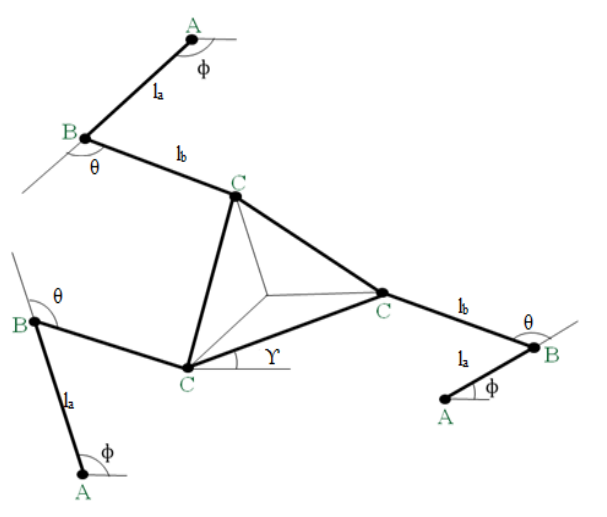
Figure 1. The 3RRR planar parallel